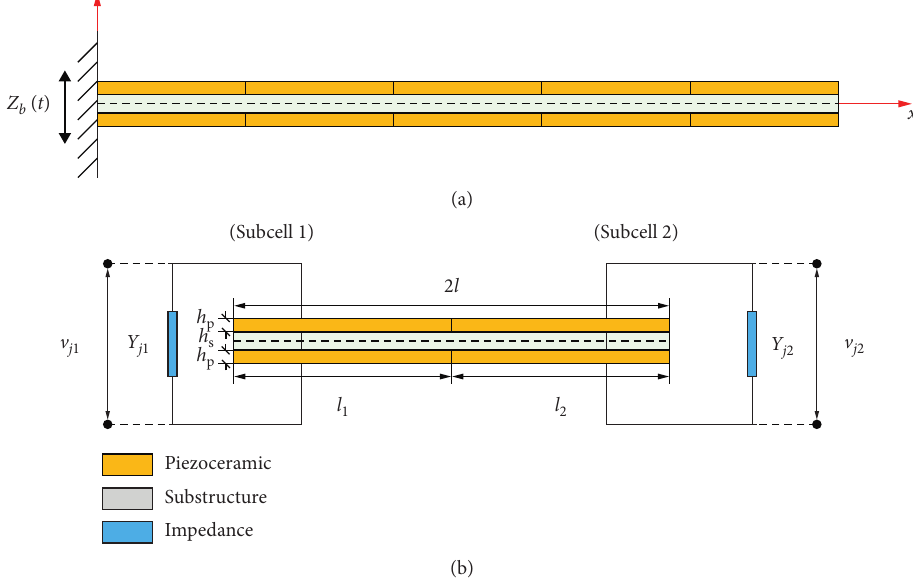
Figure 1: Simplified structural modal: (a) locally resonant metamaterials beam and (b) unit